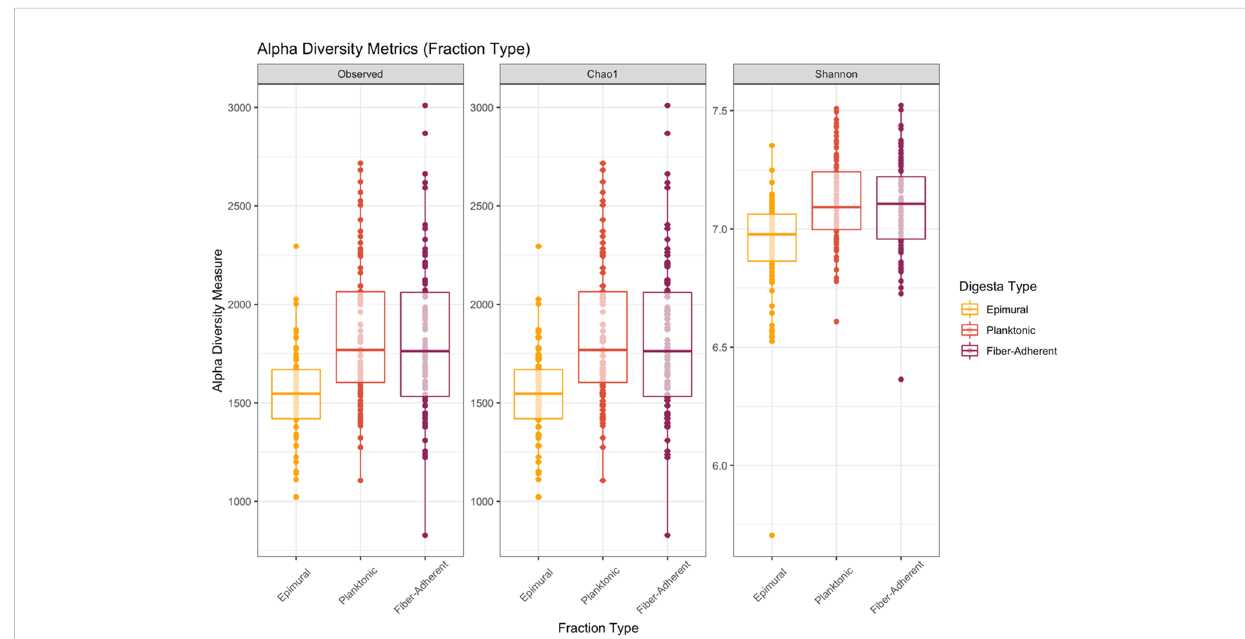
FIGURE 1 Alpha diversity metrics in the three rumen fractions. Alpha-diversity metrics for bacterial communities. Measures include observed ASVs (richness), Chao1 (expected richness), and Shannon diversity index (richness and evenness) for each digesta fraction. The epimural fraction is represented by orange, the planktonic digesta fraction is represented by red, and the fi ber-adherent digesta fraction is represented by purple. With the removal of singletons during data analysis, the Chao1 measurement may appear similar to the observed measurement. Signi fi cance was determined at P <